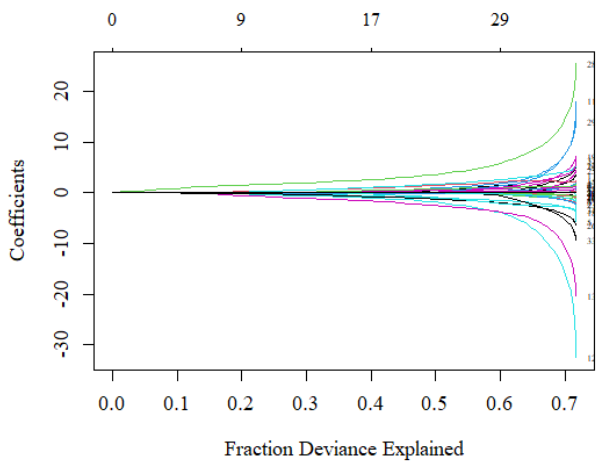
Figure 3. The fraction of deviance explained on the training data when using different numbers of variables. The coefficients of the variables did not differ a lot when selecting 17 variables in the regression model. Table 5. The prediction performance of the three regularized regression models. The best model that had the highest AUC value was a Lasso model by using λ = 0.037 and α =